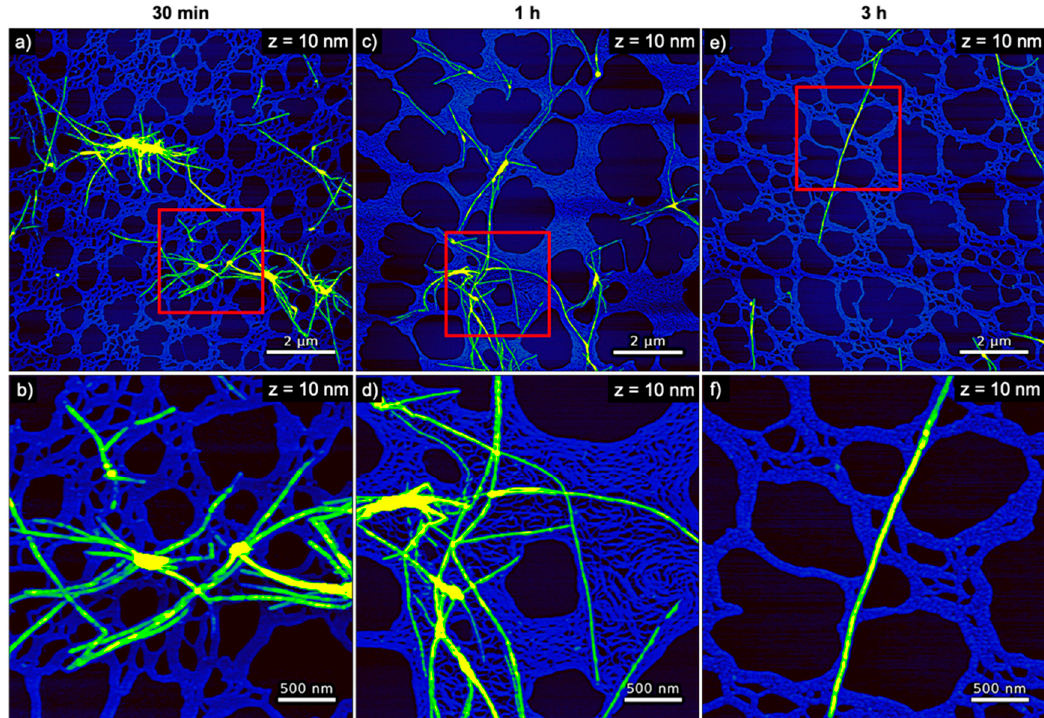
Figure 5. AFM images of hIAPP incubated with genomic dsDNA for ( a , b ) 30 min, ( c , d ) 1 h, and ( e , f ) 3 h. The images in ( b , d , f ) represent zooms of the regions indicated in the respective images in ( a , c , e ). The ranges of the z-scales are given in the individual image.